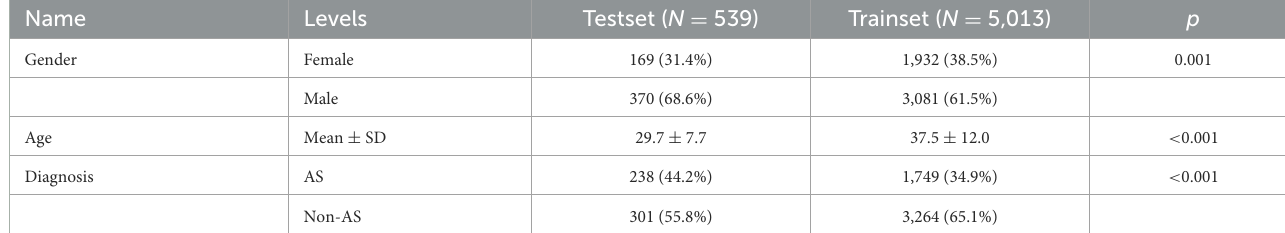
TABLE 1 Characteristics of the study subjects of the DL